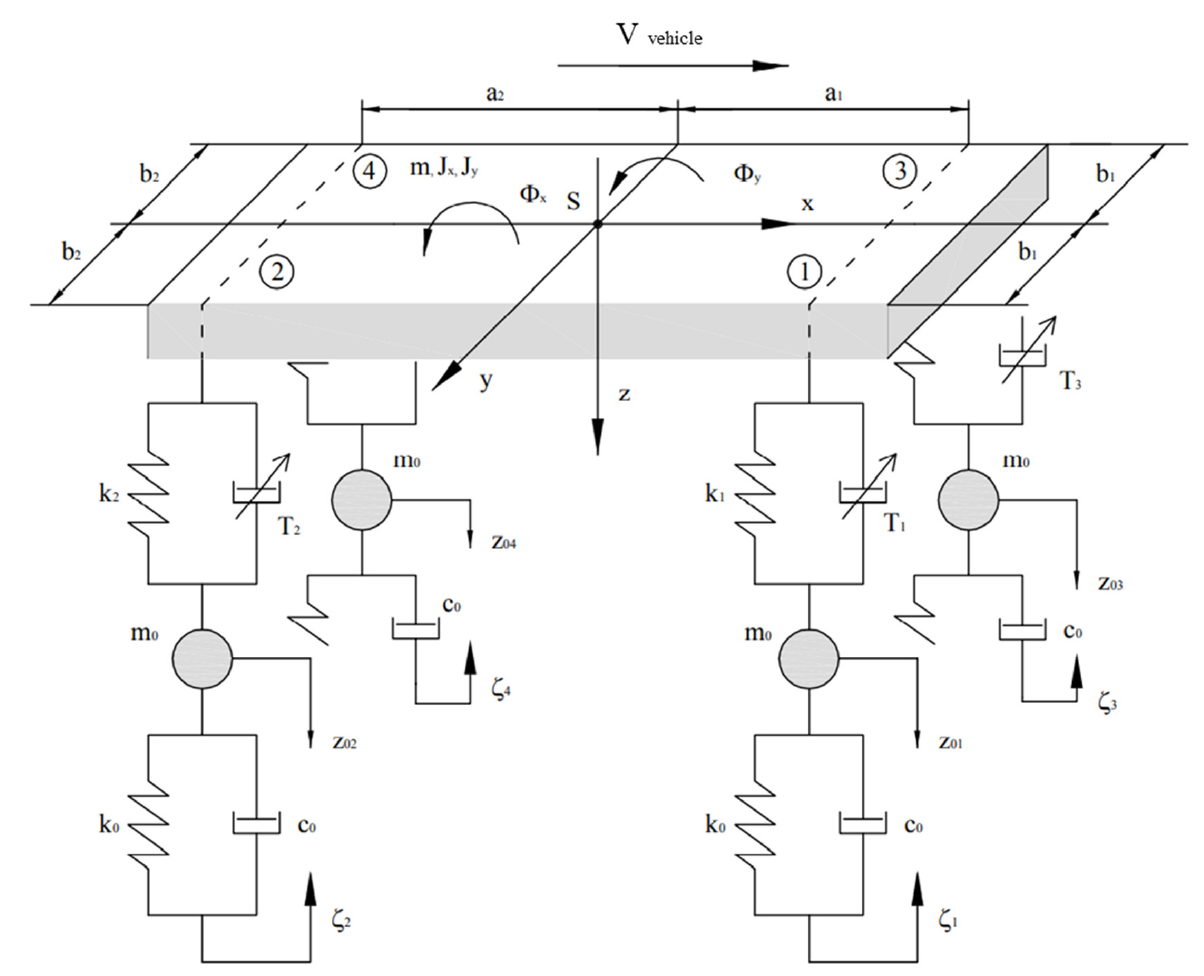
Figure 7. Scheme of the mechanical system adopted as a vehicle model; S—center of mass; Z—displacement of the bodywork in the Z direction; Φ x —rotation about the X-axis; Φ y —rotation about the Y-axis; m—mass of the body; J x —moment of inertia about the X-axis; J y —moment of inertia about the Y-axis; T 1 , T 2 , T 3 , T 4 —friction forces in suspension; k 1 , k 2 , k 3 , k 4 —spring coefficients in suspension; m 0 —mass of wheel; z 01 , z 02 , z 03 , z 04 —displacement of the wheels in the Z direction; k 0 —spring coefficients in wheel; c 0 —damping coefficients in wheel; ξ 1 , ξ 2 , ξ 3 , ξ 4 kinematic excitations; Vvehicle—vehicle velocity; a 1 , a 2 , b 1 , b 2 —position of the suspension in relation to the center of mass; 1, 2, 3, 4—acceleration measurement points.